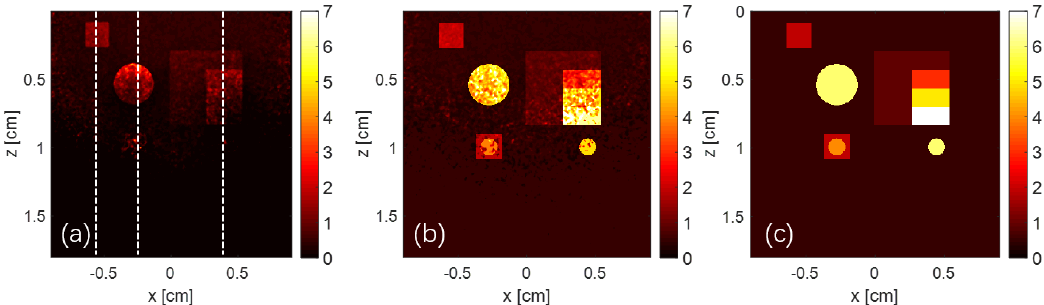
Figure 4. Three iterations were selected to visualize the results of the recovered absorption coefficient distribution, which were the results of iterations 1, 5 and 10, respectively: ( a ) the No.1 iteration recovered result; ( b ) the No.5 iteration recovered result; ( c ) the normalized No.10 iteration recovered result. The axes z and x (left and bottom) illustrate the spatial scale, the unit is cm, whereas the color scale (right) represents the absorption coefficient value, the unit is cm −1 , the white dotted line represents the three A-lines selected.